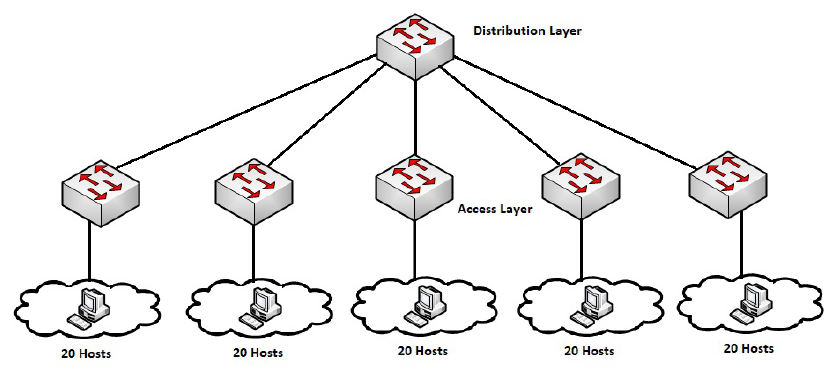
Figure 5. Simulation topology.